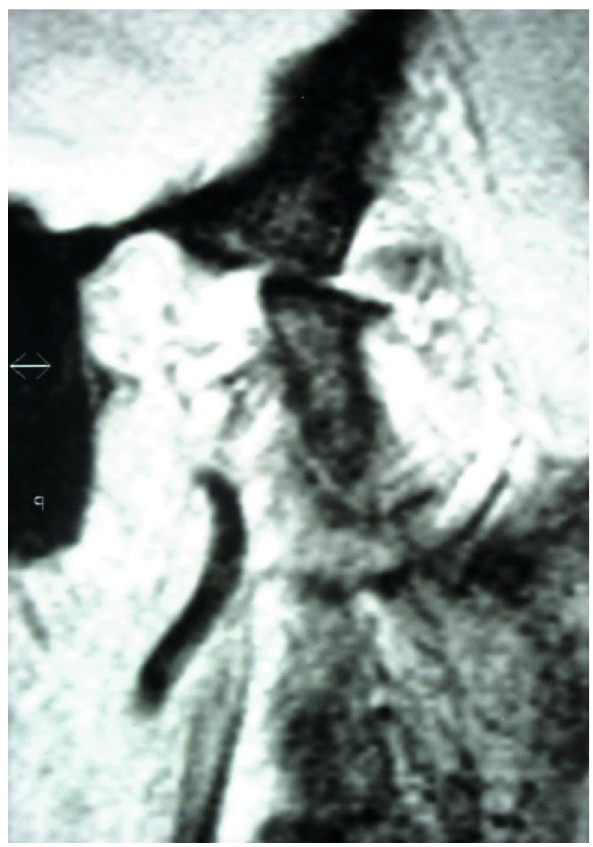
Figure 6: Representative MNR scan at 5-month follow-up. The erosive lesions on the condyle surfaces regressed, and interruption of cortical lining